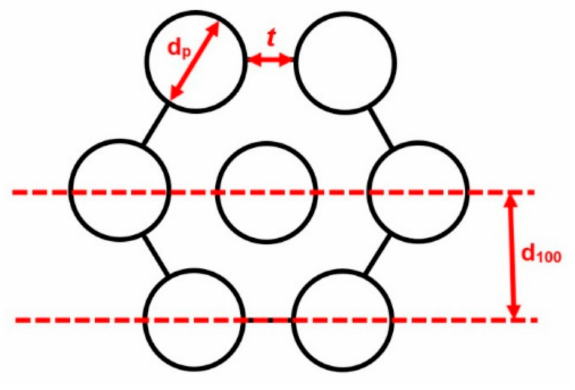
Figure 2. Schematic illustration of the hexagonal arrangement of the MCM-41 pores, indicating the (100) plane interplanar distance (d 100 ), the pore diameter (d p ), and the wall thickness ( t ). d 100 =